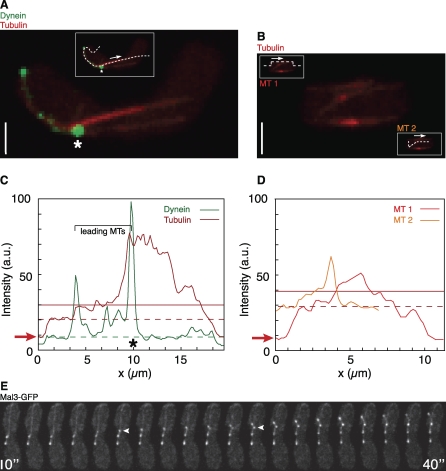
Dynein Resides along the Lateral Sides of Microtubules in Addition to the Plus Ends(A) and (C) image and the corresponding intensity profile of dynein (green) and tubulin (red) for a cell in meiotic prophase.(B) and (D) image and the corresponding intensity profile of tubulin (red) for an interphase cell of the same strain as in (A). The two cells shown in (A) and (B) were in the same field of view, 9 μm apart.(C) and (D) The intensities were measured along the white dashed lines shown in (A) and (B), respectively. The cytoplasmic tubulin signal was estimated as a difference between the cytoplasmic level (dashed red line) and the background level (red arrows). In the interphase cell, the signal of a single microtubule (horizontal solid red line), which is found in the part of the bundle near the cell tip, was ∼50% above the cytoplasmic signal (D). The signal along the leading microtubules in the meiotic cell (horizontal solid red line) was ∼100% above the cytoplasmic signal (C), indicating that there are two leading microtubules in the meiotic cell. The dynein signal (solid green line) shows several peaks along the leading microtubules, above the cytoplasmic level of dynein (dashed green line). This suggests that dynein is present along the microtubules and not only at their ends.(E) A time-lapse sequence of a cell expressing Mal3-GFP (plus end marker) during the SPB movement showing microtubule nucleation events (arrowheads). Nucleation events were identified when the signal was visible also in the previous and the subsequent image. The nucleation rate was 3.5 ± 1.2 min−1 (mean ± standard deviation, n = 105 events in three cells). Asterisks (A and C) indicate the position of the SPB. Vertical scale bars (A,B,E) represent 2 μm.